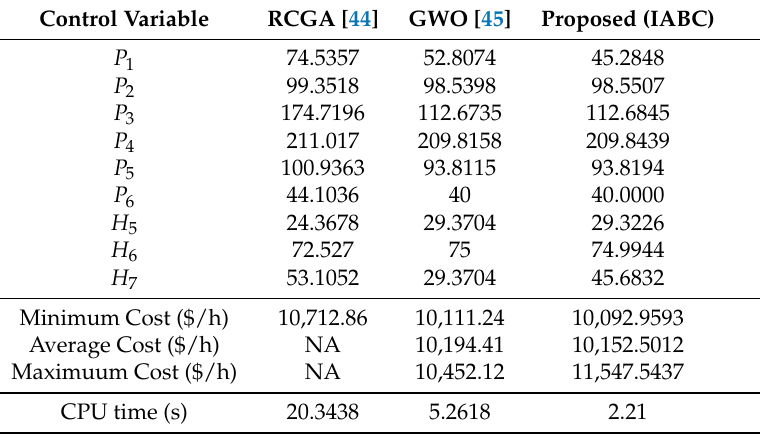
Table 8. Comparison of the obtained results for 7-unit test system (Case